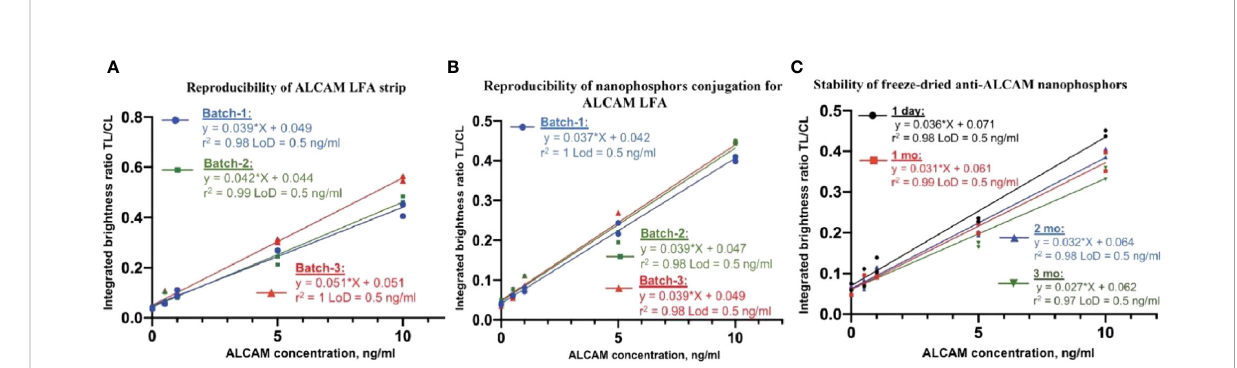
FIGURE 3 ALCAM LFA assay validation. (A) Three different batches of anti-ALCAM (pAb-1A as capture antibody) dispensed strips were assembled. One batch of anti-ALCAM (mAb-1A as detection antibody) conjugated nanophosphors was mixed with spiked running buffer-1A and loaded onto ALCAM LFA strips from three batches. No signi fi cant differences were found in linearity and LoD (0.5 ng/ml) among the three standard curves. (B) Assessing the reproducibility of anti-ALCAM nanophosphors preparation. Three batches of conjugated anti-ALCAM nanophosphors were individually mixed with spiked running buffer-1A and loaded onto the same batch of ALCAM LFA strips. No signi fi cant differences were found in linearity and LoD (0.5 ng/ml) among the three batches of conjugated anti-ALCAM nanophosphors. (C) Stability of anti-ALCAM conjugated nanophosphors. Anti-ALCAM conjugated nanophosphors were freeze-dried and then reconstituted after one day, one month, two months, and three months after storage, respectively. No signi fi cant differences were found in linearity and LoD (0.5 ng/ml) after different storage durations, verifying the stability of lyophilized nanophosphors at room